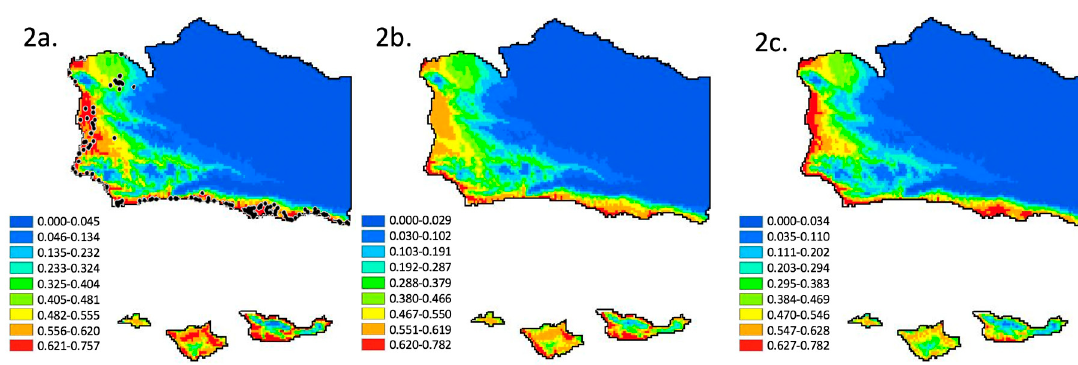
Figure 2. Results of MaxEnt climate niche analysis for the current distribution of monarch butterfly overwintering habitat in Santa Barbara County, California: ( a ) using an optimized regularization parameter, up to 35 WorldClim 2.0 layers, reduced by the “top variable uncorrelated” elimination method of Warren et al. [35] for reduction of over parameterization, and showing the location of known overwintering sites (as in Figure 1), ( b ) using an optimized regularization parameter, up to 35 WorldClim 2.0 layers, and the “uncorrelated” method modified from Warren et al. [35] for reduction of over parameterization, and ( c ) 35 WorldClim 2.0 layers, and no variable elimination or optimization method to reduce over parameterization, thus potentially allowing for over parameterization. Relative probabilities are indicated by the color legend. All models show similar probabilities, suggesting a current distribution in the coastal zone and extending into coastal valleys to a lesser or greater degree. Addressing over parameterization does not impact our ability to predict the current range.